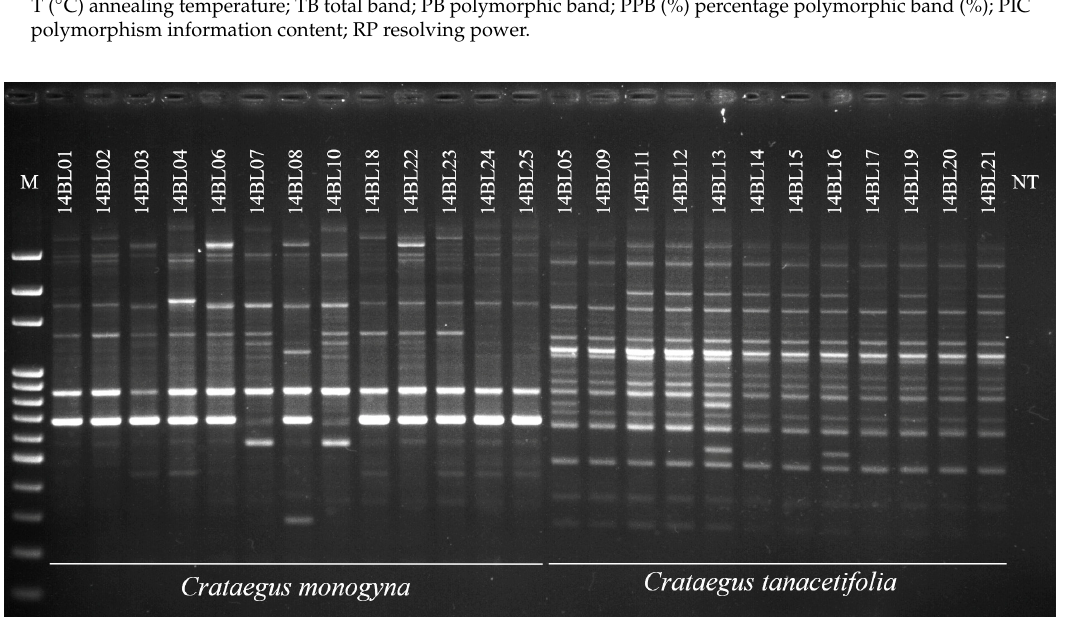
Figure 4. A representative DNA profile of hawthorn genotypes obtained with inter-priming binding sites (iPBS)2074 primer. M: 100 bp DNA Ladder (Solis BioDyne, Tartu, Estonia). NT: non-template